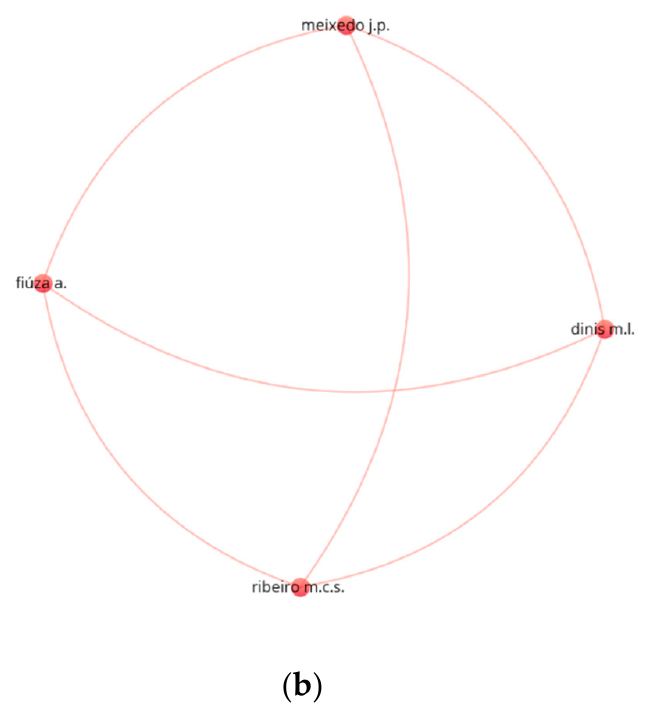
Figure 7. Visualization of co-authorship; ( a ) authors with minimum five documents; ( b ) connected authors.